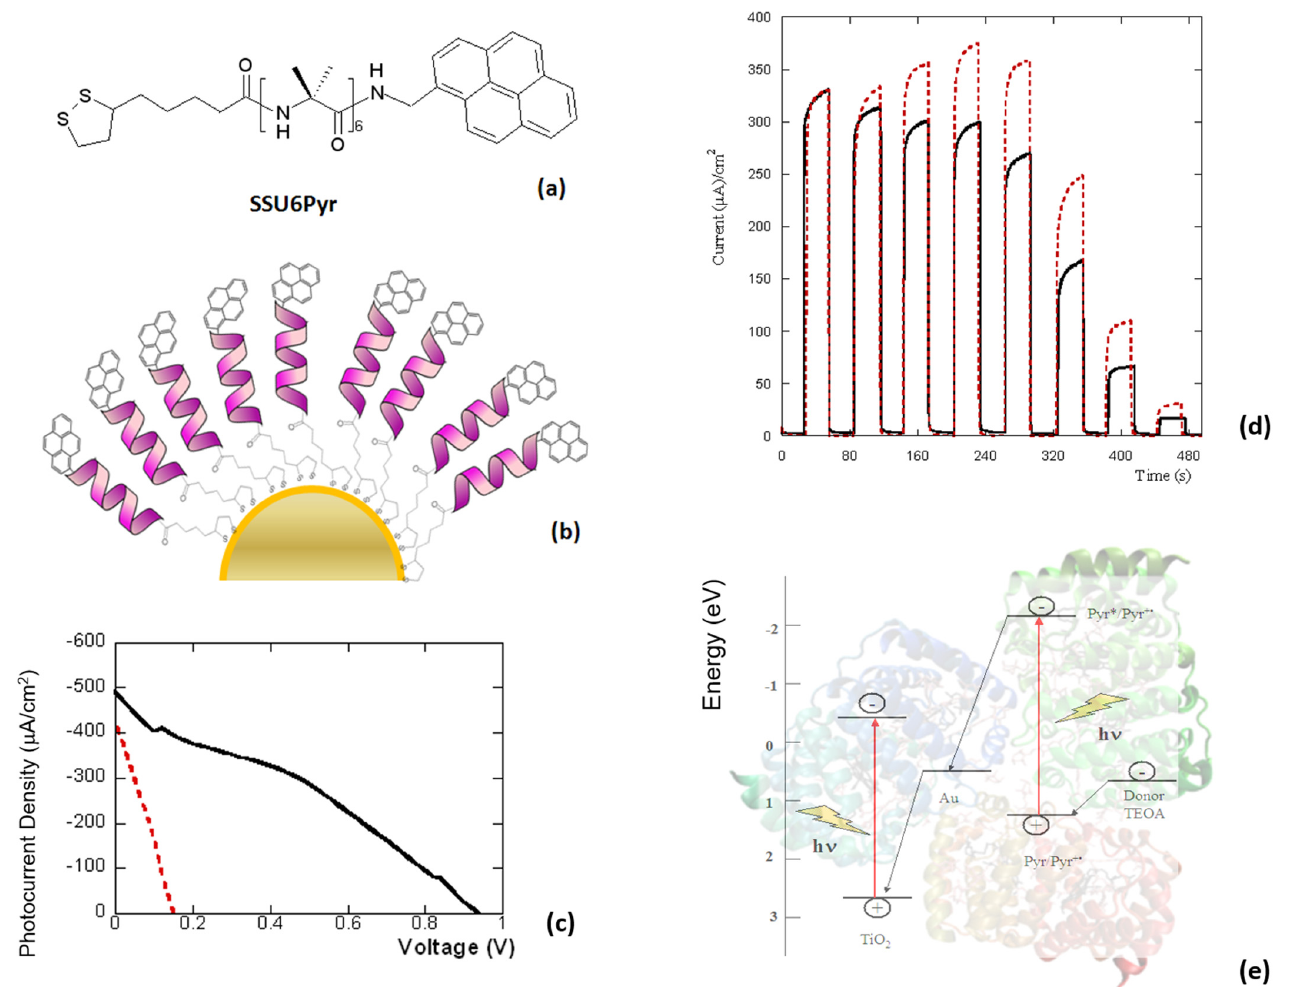
Figure 4. ( a ) Chemical formula and acronym of the peptide investigated in the work of the authors of [88]. ( b ) Schematic representation of the peptide on the gold-covered TiO 2 nanostructured surface. ( c ) Photocurrent vs. voltage behavior of the peptide-based cell (black solid curve). The photoresponse of the Au/TiO 2 /FTO electrode is also reported for comparison (red dotted line). ( d ) Time course of the photocurrent generated by the SSU6Pyr film on the Au/TiO 2 /FTO electrode (dotted red line) as compared to the bare Au/TiO 2 /FTO electrode (continuous black line) and to the pyrene chromophore adsorbed on the Au/TiO 2 /FTO electrode (dashed grey line). The measurements have been performed in aqueous TEOA solution, at 0 V vs. Ag/AgCl, upon photoirradiation at different wavelengths (every 10 nm from 320 to 390 nm). ( e ) Schematic representation of the energy levels involved in the photocurrent process. Reproduced with permission from ref. [88], copyright Wiley.